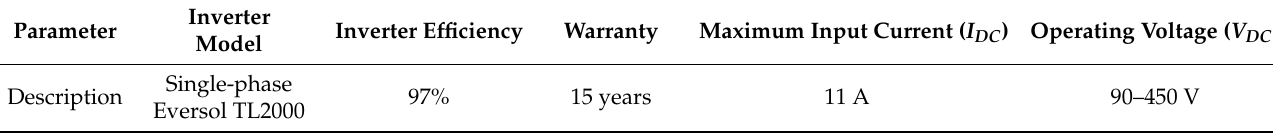
Table 11. Inverter specifications